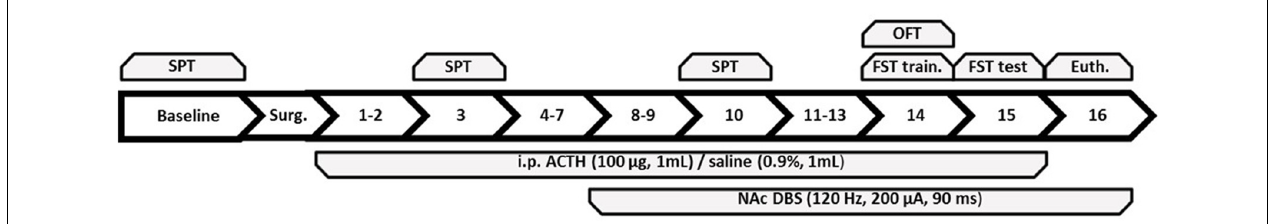
FIGURE 1 | Summary of the experimental timeline with each number corresponding to the day following baseline and surgery. Behavioral tests administered to all groups are on top of the figure and treatments are below. SPT, sucrose preference test; OFT, open field test; FST, forced swim test; train., training; Euth., euthanasia; ACTH, adrenocorticotropic hormone; NAc DBS, nucleus accumbens deep brain stimulation.